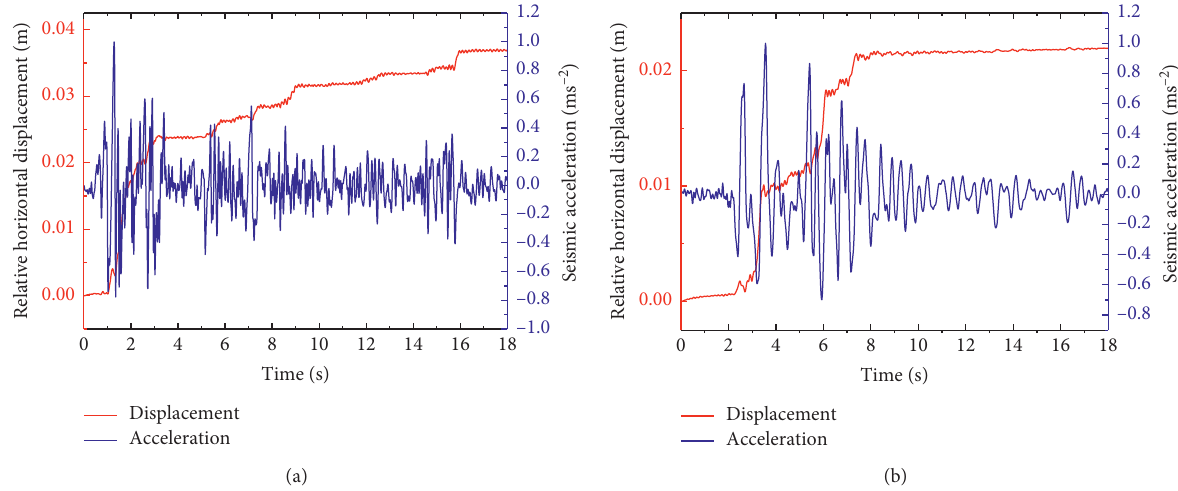
Figure 5: Cumulative effect of slope displacement. (a) Relative horizontal displacement and acceleration curves of Kobe earthquake time series. (b) Relative horizontal displacement and acceleration curves of EI Centro earthquake time